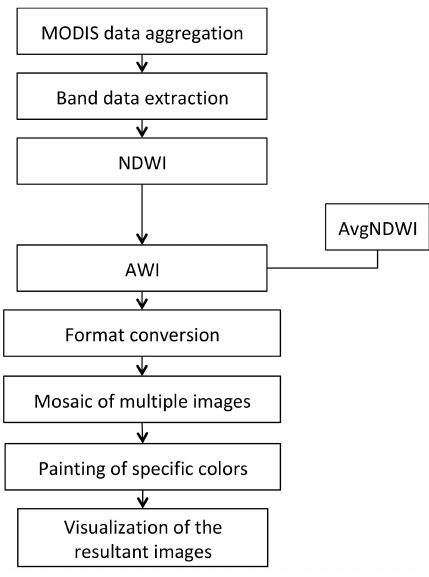
Figure 1. Flow chart of vegetation drought monitoring model.